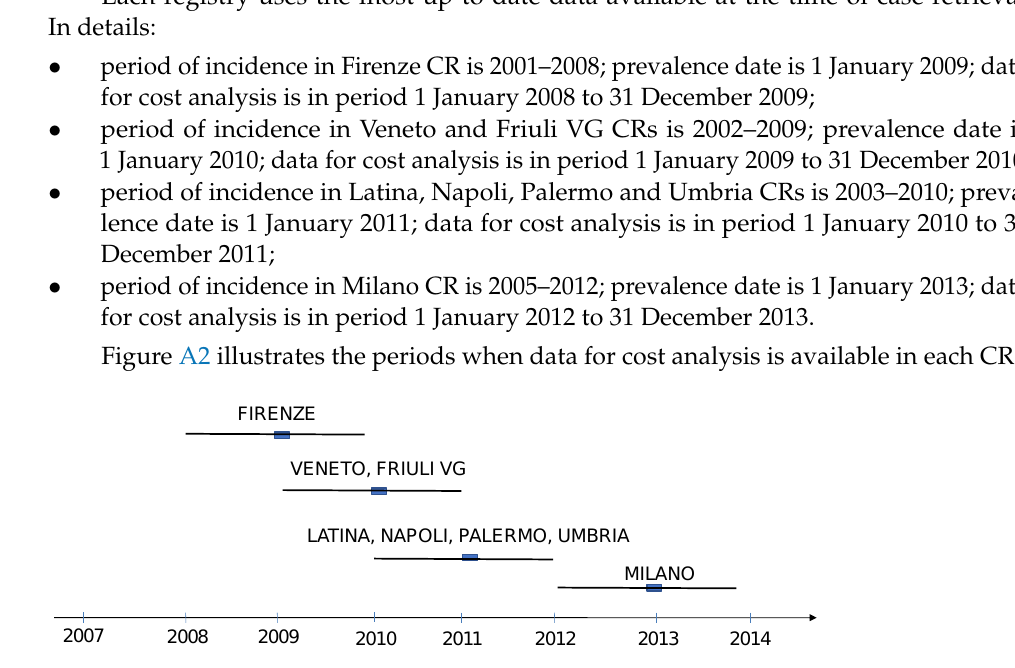
Figure A2. Periods of data availability for cost analysis in each CR.